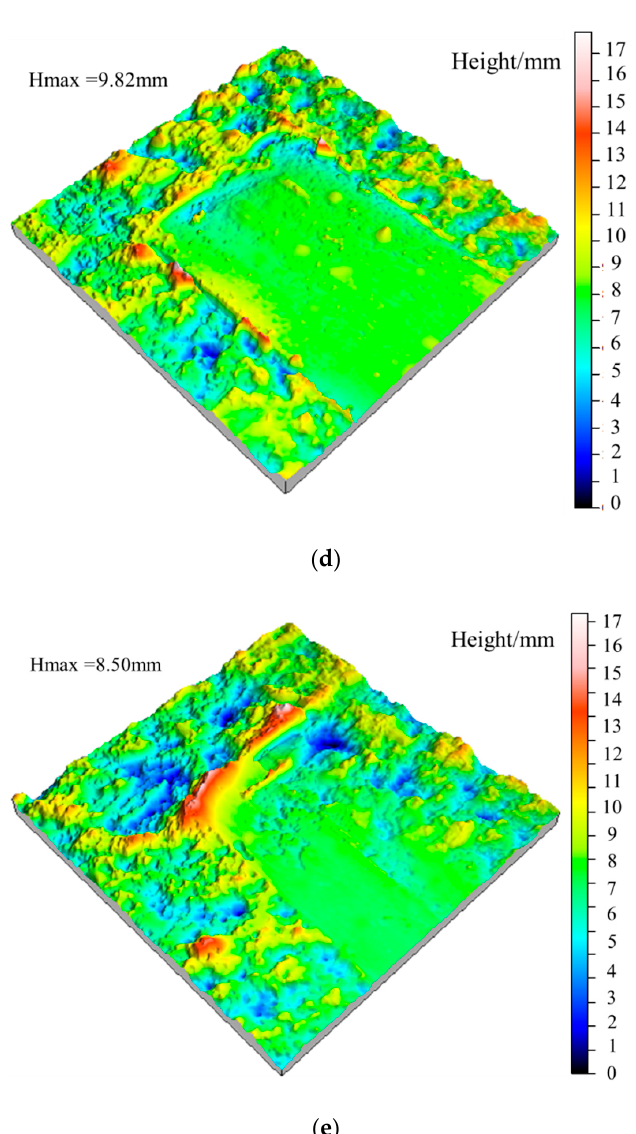
Figure 9. Original 3D morphology of the shear surface under freeze-thaw cycles after the second shear test. ( a ) Zero freeze-thaw cycles. ( b ) Ten freeze-thaw cycles. ( c ) Twenty freeze-thaw cycles. ( d ) Thirty freeze-thaw cycles. ( e ) Forty freeze-thaw cycles.